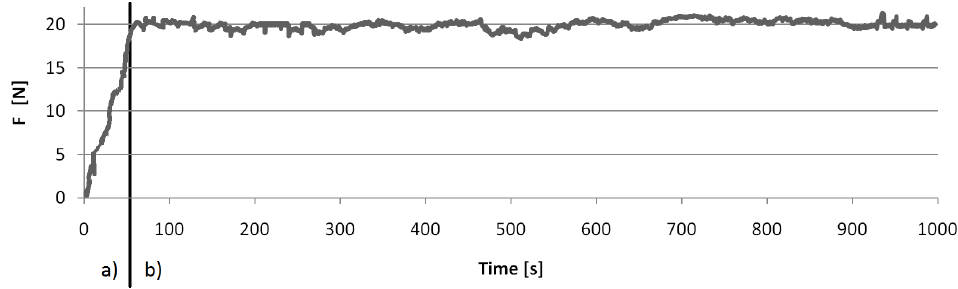
Figure 5. Example time profile of the friction force obtained during one of the tests: ( a ) running-in; ( b ) measurement period proper.